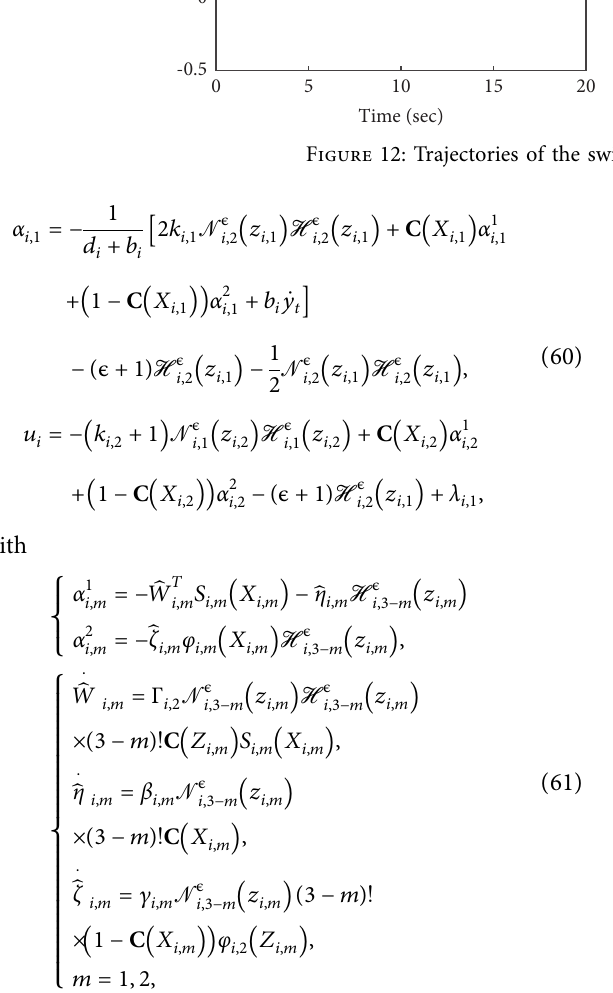
Figure 12: Trajectories of the switching signals C ( X